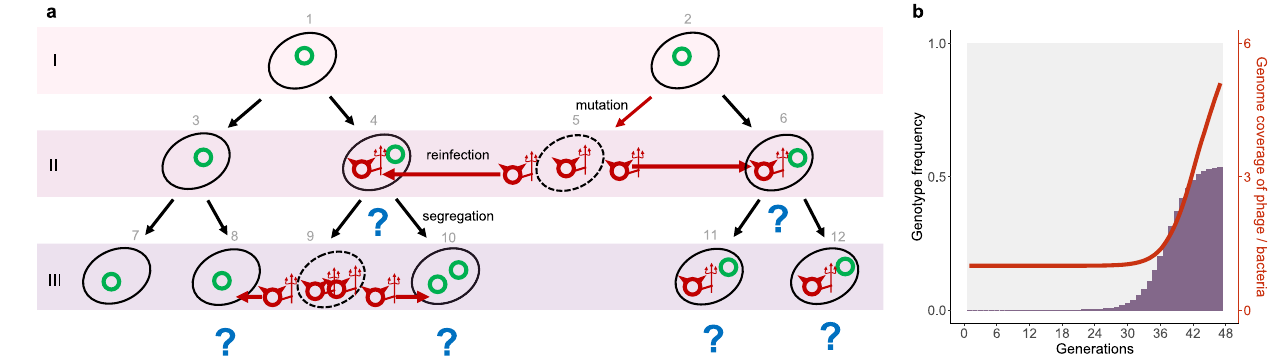
Fig. 3 | A minimal model for phage-plasmid hybrid reproduces the observed eco-evolutionary dynamics. a Schematic illustration of the model simulation. A question mark is drawn under a host cell when it carries more than one copies of phage-plasmids with different genotypes (a heterozygote). In those cases, the phage-plasmid genotype in descendants becomes stochastic due to segregational